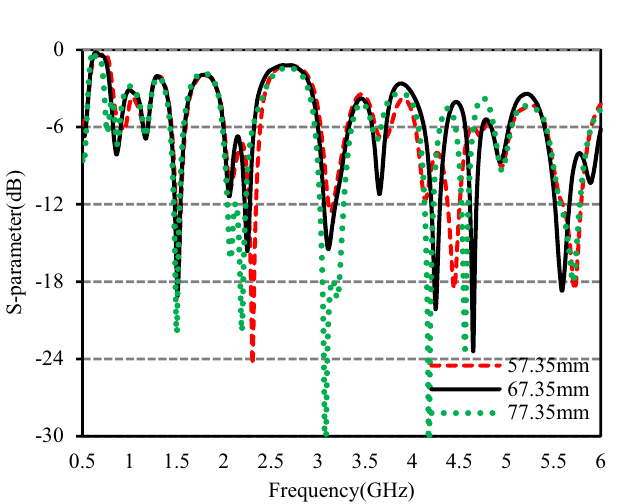
Figure 7. S-parameters for different values of W 3 .